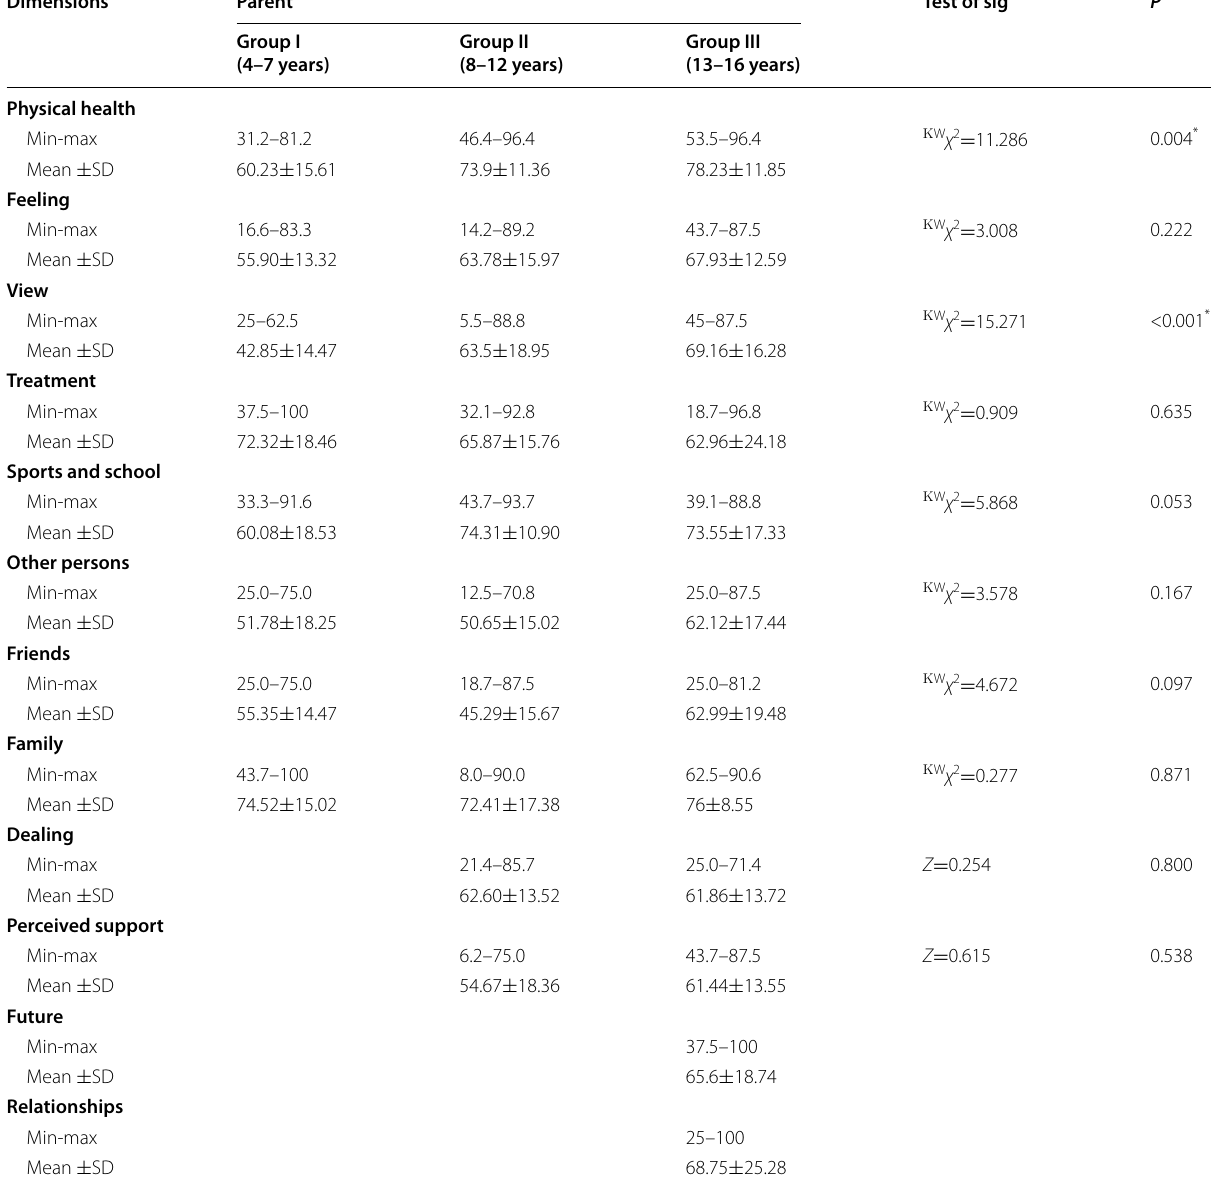
Table 4 Comparison between the parent Haemo-QoL score dimensions among the different age groups